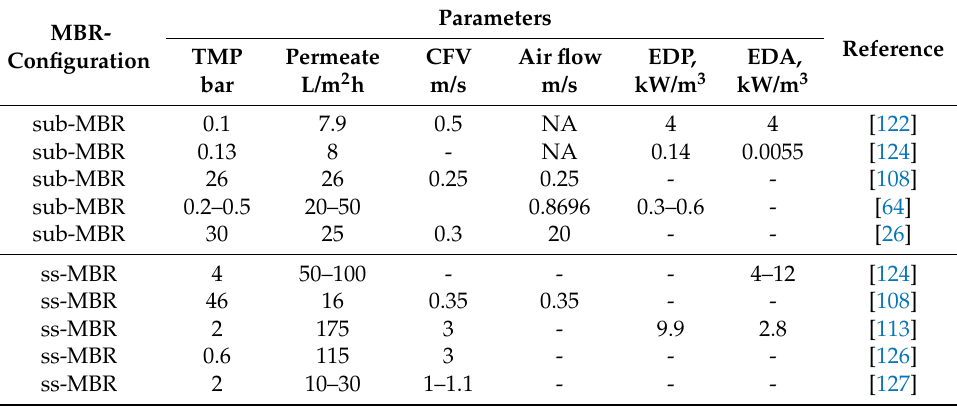
Table 2. Published data on the effect of configurations on